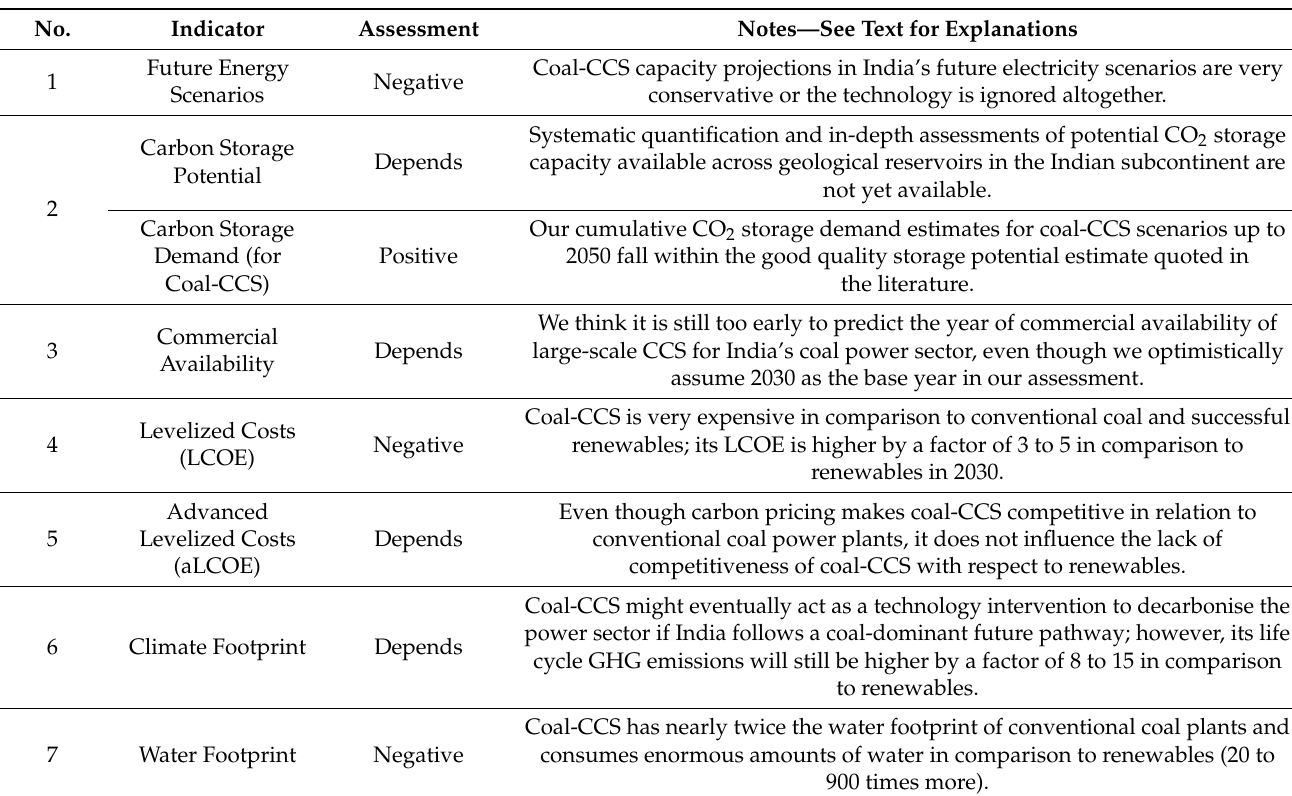
Table 2. A comprehensive overview of our integrated assessment results with respect to the seven chosen indicators. No.